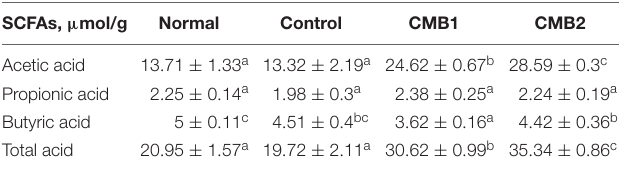
CMB1 group: (combining multiple strains of Bifidobacterium with adhesion property), 1 × 10 10 CFU; CMB 2 group: (combining multiple strains of Bifidobacterium with no adhesion property), 1 × 10 10 CFU. a − c Mean values with different letters over bars are significantly different (p < 0.05) according to Duncan’s multiple range